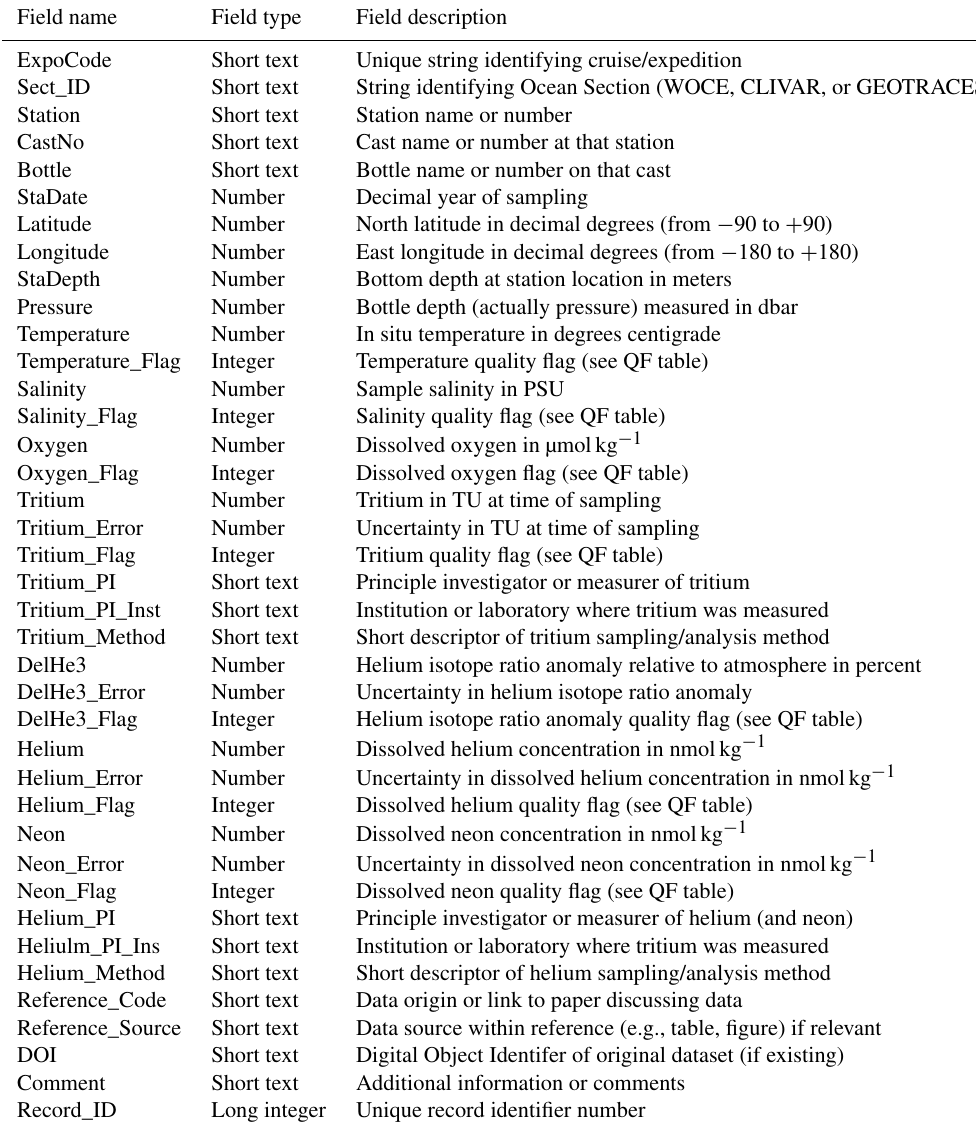
Table 1. Fields (columns) in the main data